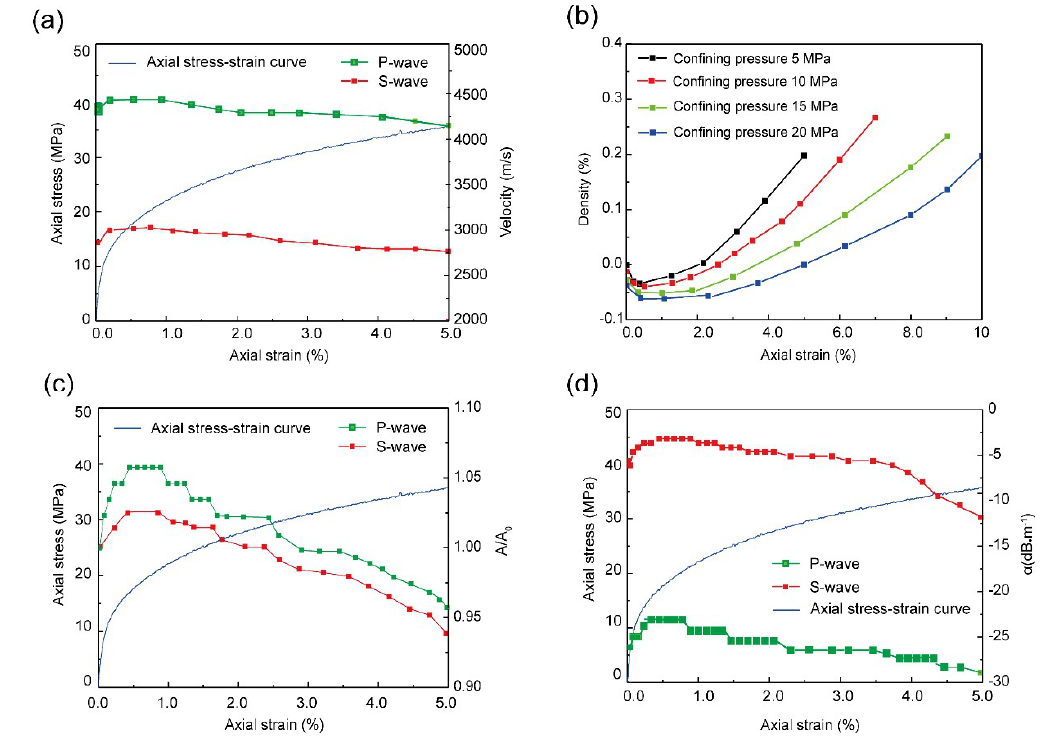
Figure 5. Ultrasonic wave characteristics of rock salt under a triaxial loading test: ( a ) the relationship of ultrasonic wave velocity and axial stress–stain curve; ( b ) the relationship of crack density and axial stress–stain curve; ( c ) the relationship of ultrasonic wave amplitude and axial stress-stain curve; and, ( d ) the relationship of ultrasonic wave attenuation coefficient and axial stress–stain curve.